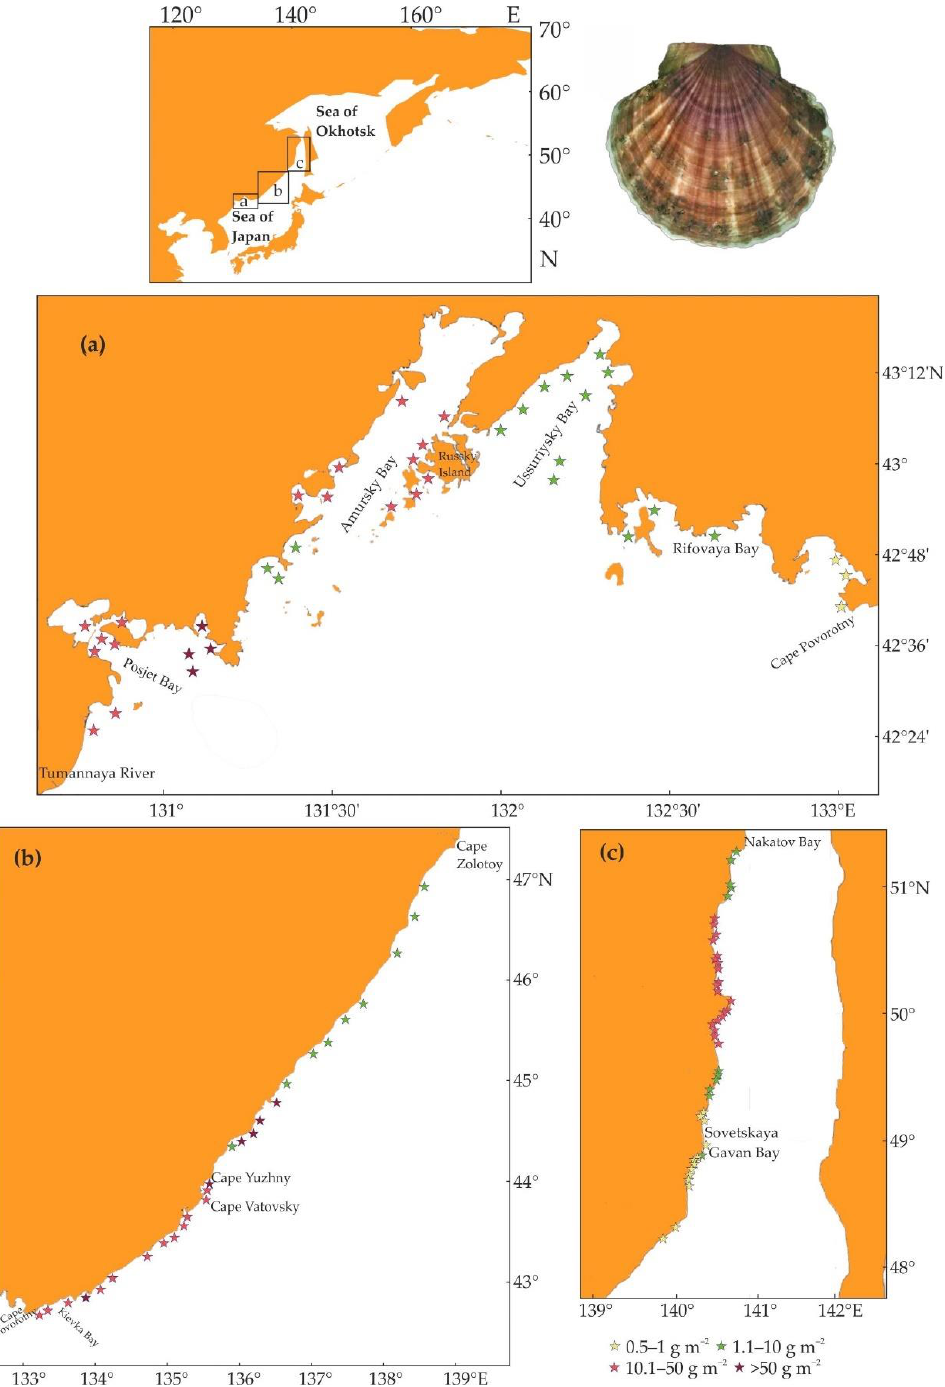
Figure 3. Location of major Mizuhopecten yessoensis beds in Russian waters of the Sea of Japan. ( a ) Peter the Great Bay, ( b ) coastal zone between Cape Povorotny and Cape Zolotoy, ( c ) Tatar Straight (modified from